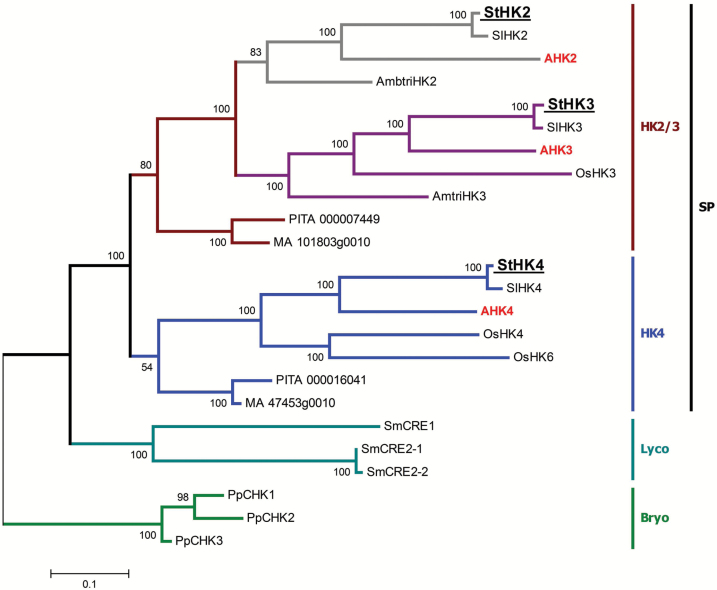
Phylogenetic tree of CK receptors. Species are shown as follows: AHK2-4, Arabidopsis; AmbtriHK2,3, Amborella trichopoda; PpCHK1-3, Physcomitrella patens; SmCRE1,2-1,2-2, Selaginella moellendorffii; MA 101803g0010 and MA 47453g0010, Picea abies; OsHK3,4,6, Oryza sativa; PITA 000007449 and PITA 000016046, Pinus taeda; SlHK2-4, Solanum lycopersicum; StHK2-4, Solanum tuberosum. SP, seed plants; Lyco, Lycophyta; Bryo, Bryophyta. Parameters of the maximum likelihood algorithm were: phylogeny test—bootstrap method; no. of bootstrap replications, 100; substitutions type, amino acid; model, equal input model; rates among sites, gamma distributed; no. of discrete gamma categories, three; gaps/missing data treatment, complete deletion; ML heuristic method, subtree-pruning, regrafting.